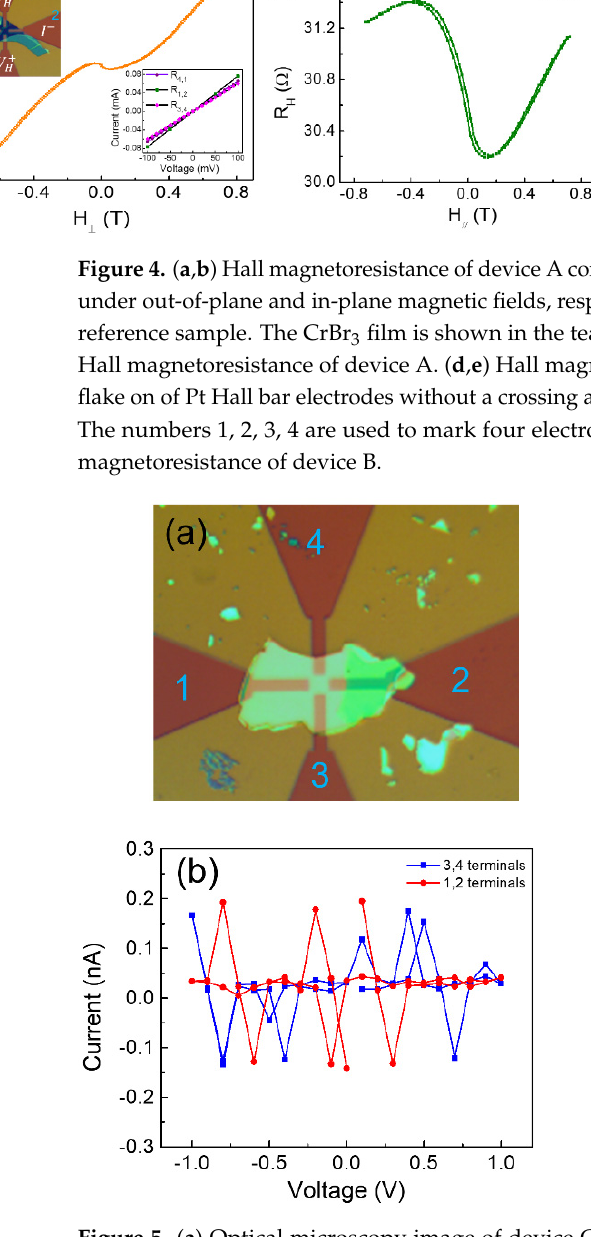
Figure 5. ( a ) Optical microscopy image of device C consisting of a fresh and thick CrBr 3 flake on Pt Hall bar electrodes without a crossing area. The thick CrBr 3 flake is shown in the light yellow area; ( b ) I–V curves of the CrBr 3 flake in device C. The numbers 1, 2, 3, 4 are used to mark four electrode ports.